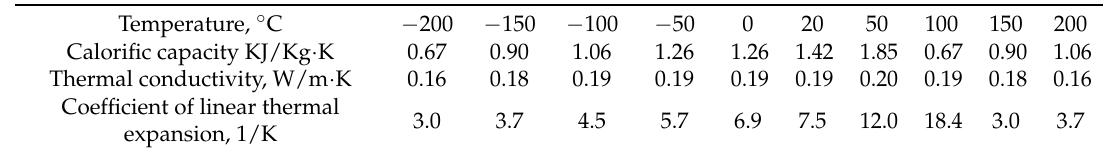
Table 1. Physical properties of poly (methyl methacrylate)